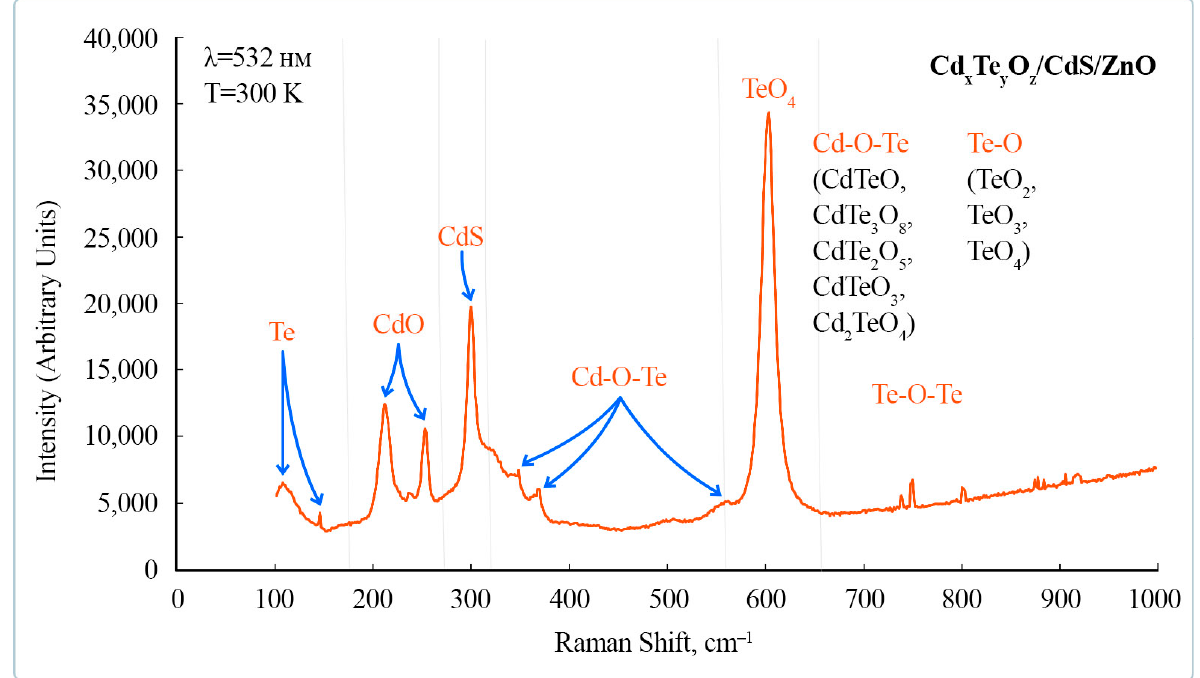
Figure 6. Raman sca tt ering spectra of the Cd x Te y O z /CdS/ZnO heterostructure. Figure 6. Raman scattering spectra of the Cd x Te y O z /CdS/ZnO heterostructure. Spectra from the ZnO substrate were not recorded. This indicates the complete over- Spectra from the ZnO substrate were not recorded. This indicates the complete growth of the surface with cadmium-containing fi lms of su ffi cient thickness. The intense overgrowth of the surface with cadmium-containing films of sufficient thickness. The peak at 300 cm − 1 is due to the main LO phonon mode of CdS. This peak is asymmetric intense peak at 300 cm − 1 is due to the main LO phonon mode of CdS. This peak is toward a higher frequency compared to the typical spectrum of bulk CdS (305 cm − 1 ). It asymmetric toward a higher frequency compared to the typical spectrum of bulk also contains minor peaks at 248 and 369 cm − 1. which may indicate the presence of particles with a large spread in size.